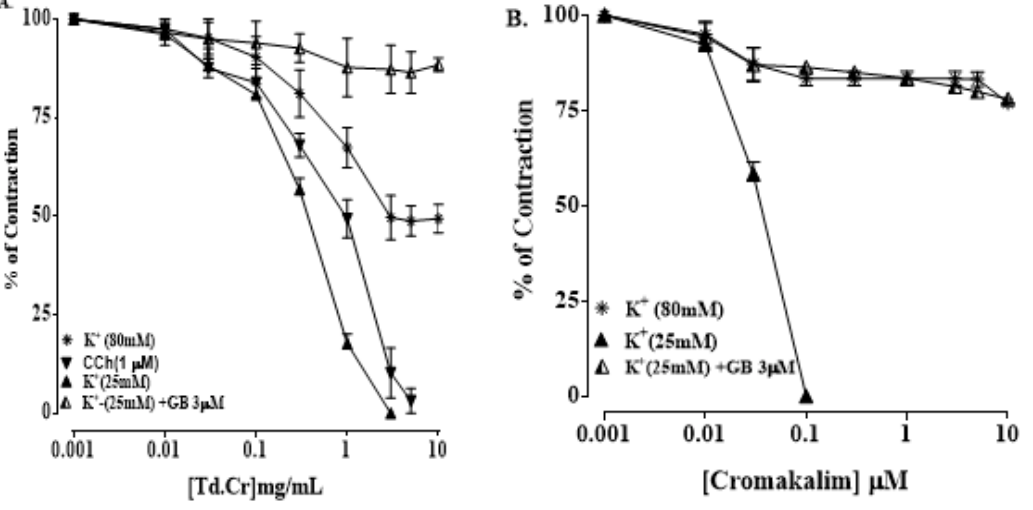
Figure 7. Concentration-response graphical presentation of ( A ) TdCr compared with ( B ) cromakalim (1 μ mol/L) on K+ (80 mmol/L) and K+ (25 mmol/L)-provoked contractions in the absence or presence of glibenclamide (3 μ M) isolated rabbit tracheal preparations. Values shown as mean ± SEM, n = 5.